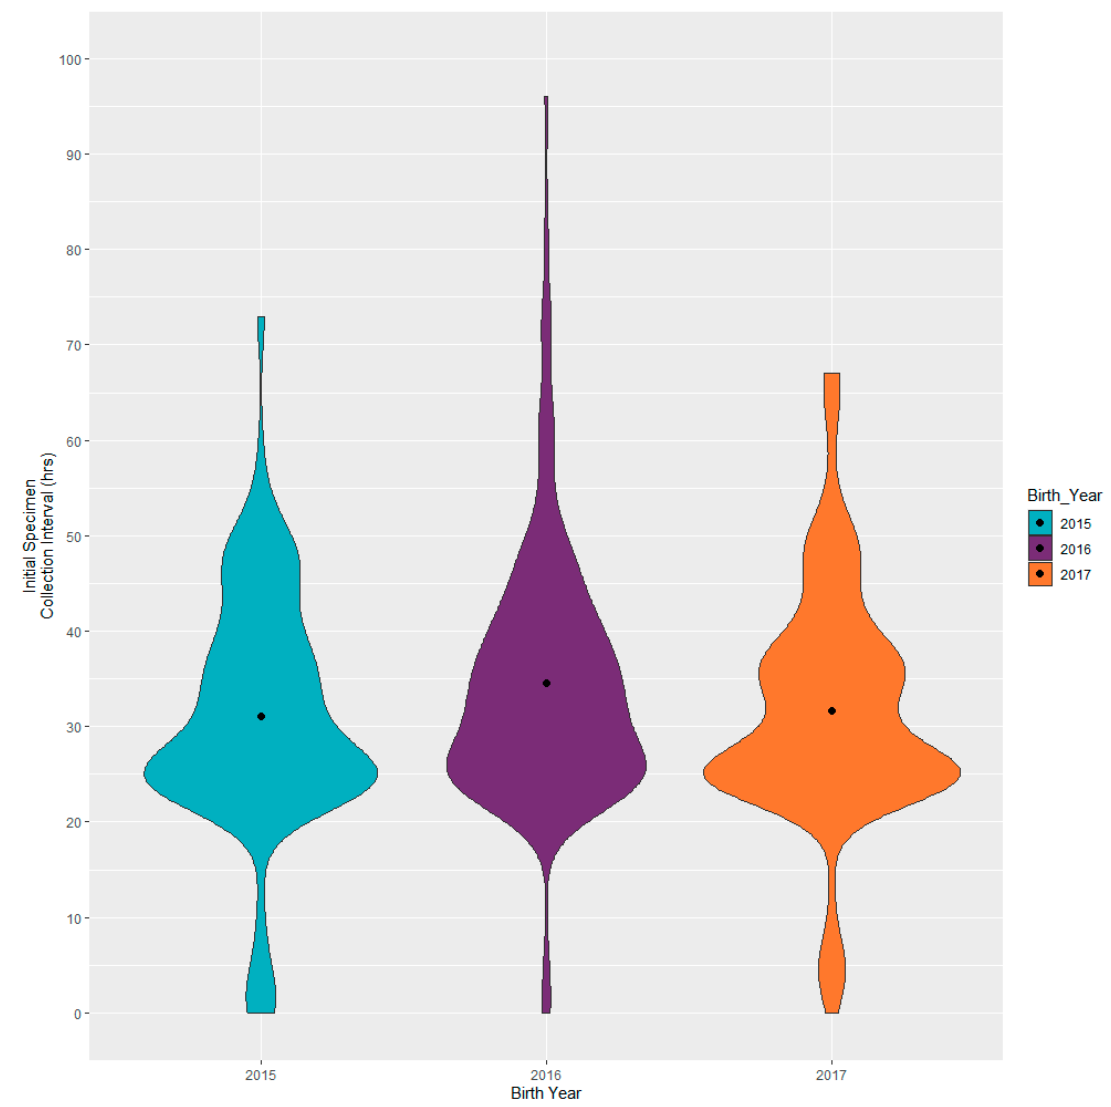
Figure 7. Congenital adrenal hyperplasia cases: time from birth to specimen collection in hours ( N =